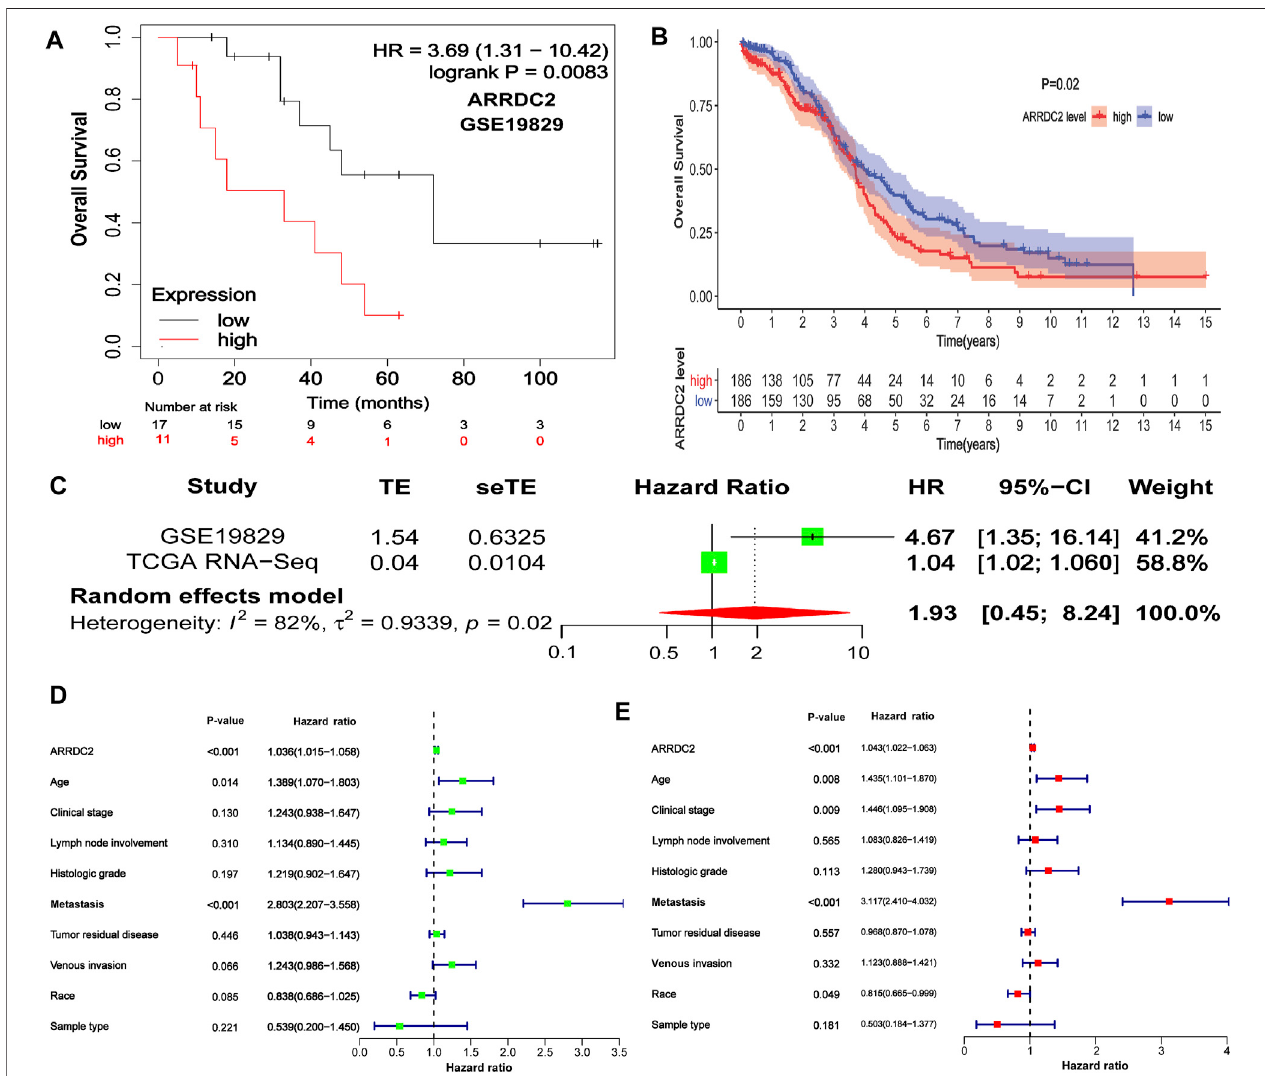
FIGURE2| ThecorrelationbetweenARRDC2andthepoorprognosisofpatientswithOV. (A) TheKaplan-Meiersurvivalcurverevealedthatthehighexpressionof ARRDC2 lead to a poor prognosis in OVs (GSE19829, N = 28, p = 0.0083). (B) The Kaplan-Meier survival curve revealed that the high expression of ARRDC2 lead to a poor prognosis in OVs (TCGA, N = 372, p = 0.02). (C) Forest plot of high ARRDC2 expression with poor OS in OV patients based on survival meta-analysis of two datasets(GSE19829andTCGA RNA-Seq, p =0.02). (D,E) Analysisofunivariateand multivariate factorsaffectingtheprognosisofpatientswithOV. (D) Univariate cox analysis. (E) Multivariate cox